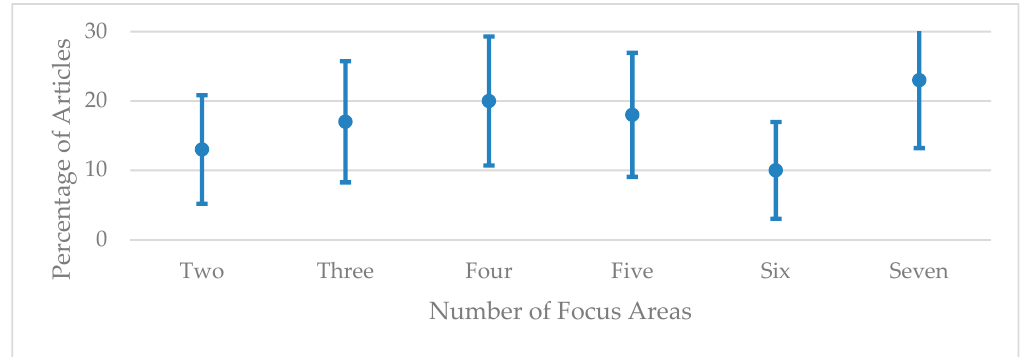
Figure 8. The research focus areas (± 95% CIs of the proportions) reported by articles identified in the initial search reported by this review (n = 71).